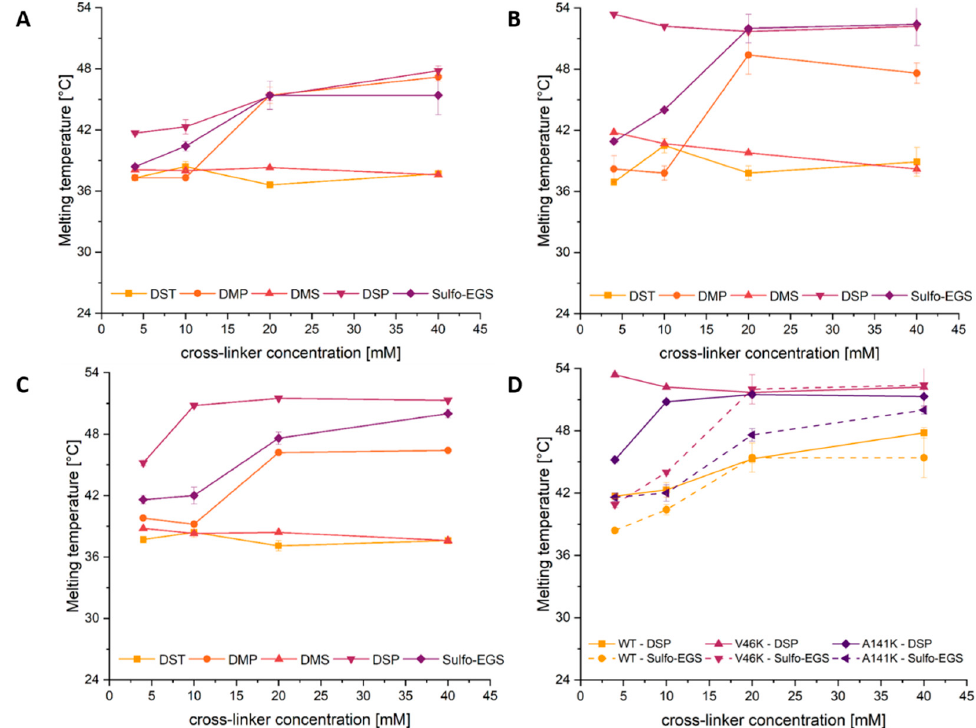
Figure 3. Influence of the concentration of different cross-linkers on CLEC stability. Apparent melting temperatures of CLECs of wild-type HheG ( A ) as well as variants V46K ( B ) and A141K ( C ) were determined after cross-linking with five different cross-linkers and using increasing cross-linker concentrations. ( D ) Comparison of the different CLEC variants cross-linked with either DSP or Sulfo-EGS. Melting temperatures were determined in triplicate.